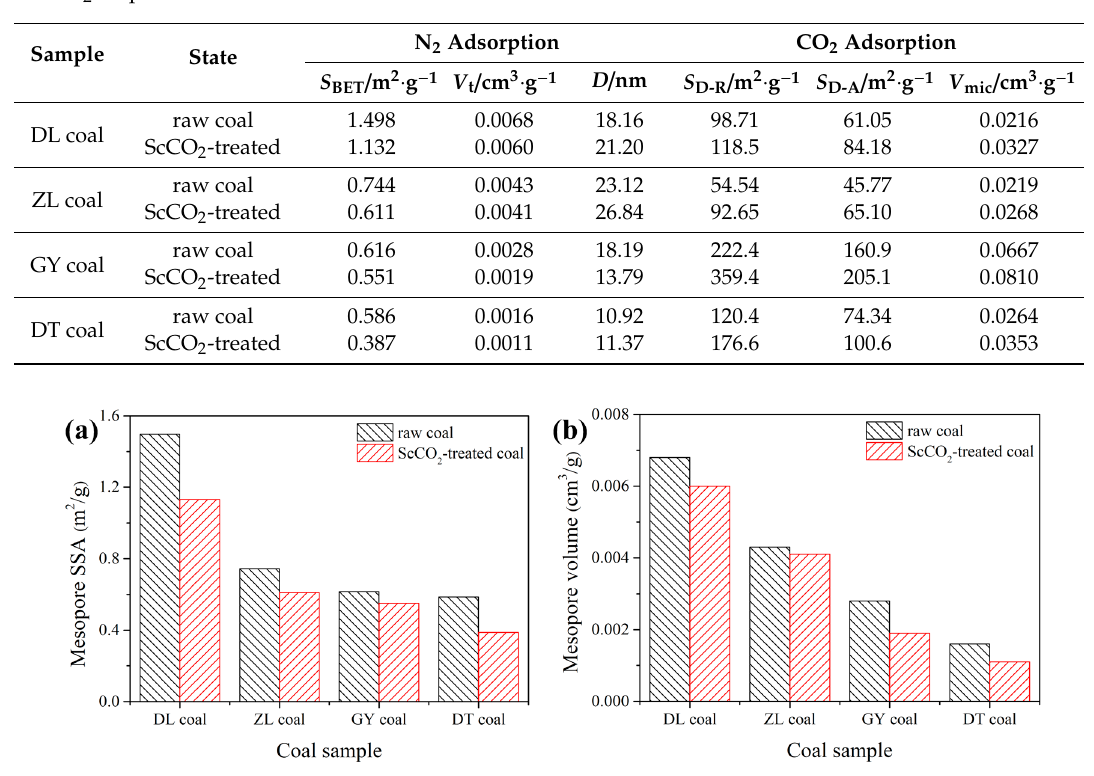
Figure 6. Mesopore specific surface area (SSA) and volume of the raw and ScCO 2 -treated coal samples: ( a ) mesopore SSA; ( b ) mesopore volume.